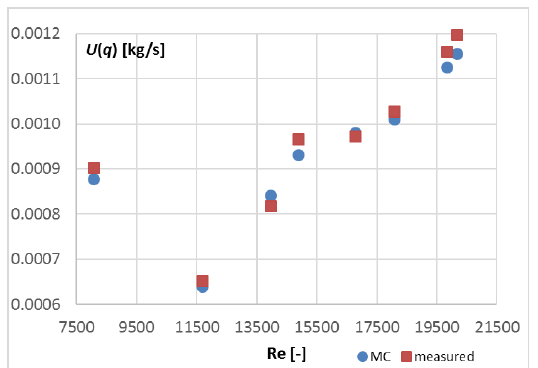
Fig. 5 . Comparison of the extended uncertainty U ( q ) for the simulation and